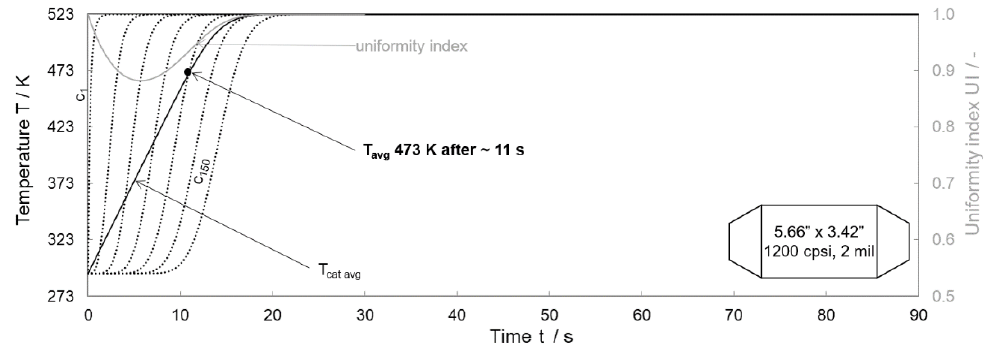
Figure A7. Heat-up of 1200 cpsi, 2 mil with reduced length at steady state heat-up.